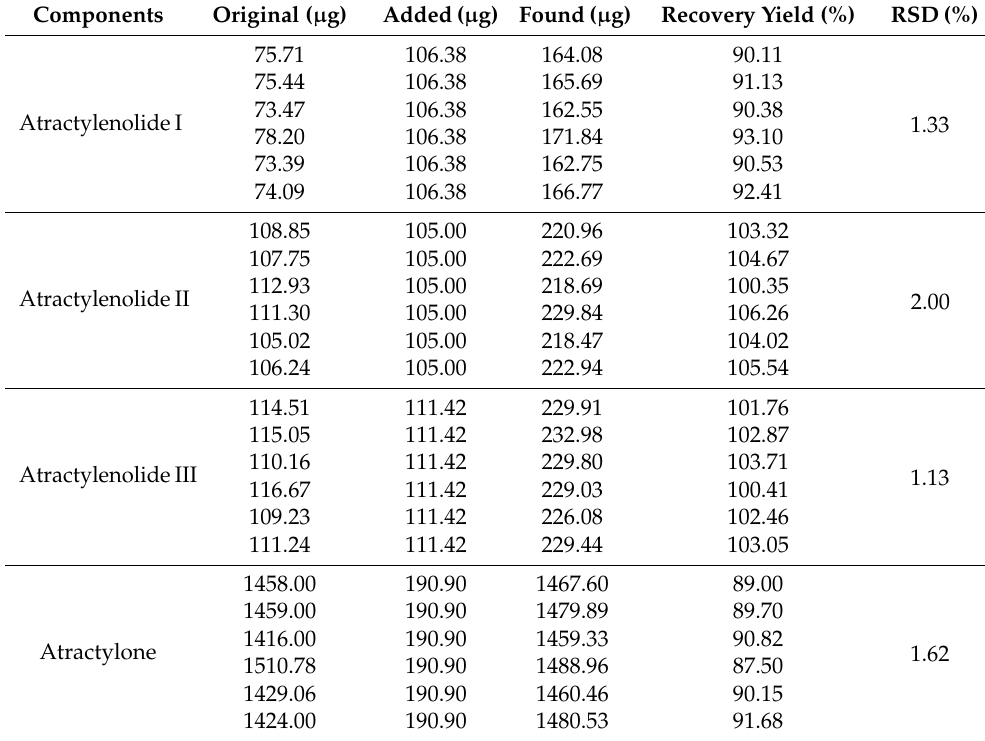
Table 4. The recovery rate of four compounds.